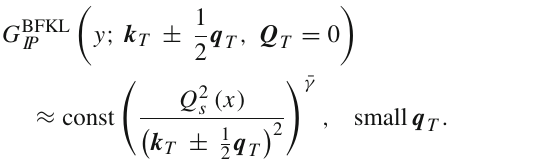
(cid:3) (cid:2) 2 + 2 ¯ γ discussed + (cid:13) 2 q 2 c T